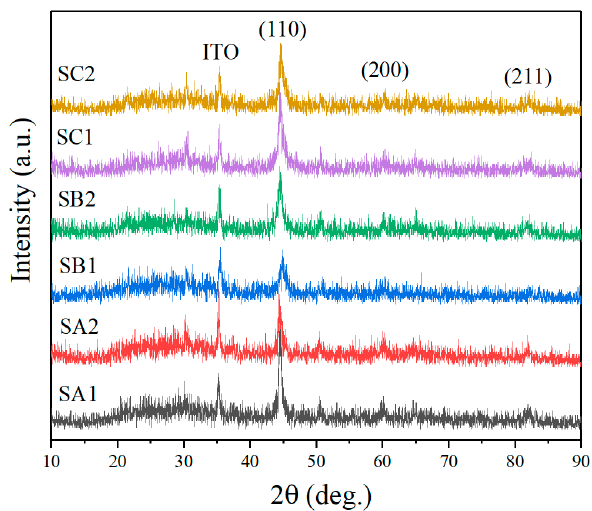
Figure 1. X-ray diffraction (XRD) spectra for SA1, SA2, SB1, SB2, SC1, and SC2. Figure 1. X-ray di ff raction (XRD) spectra for SA1, SA2, SB1, SB2, SC1, and